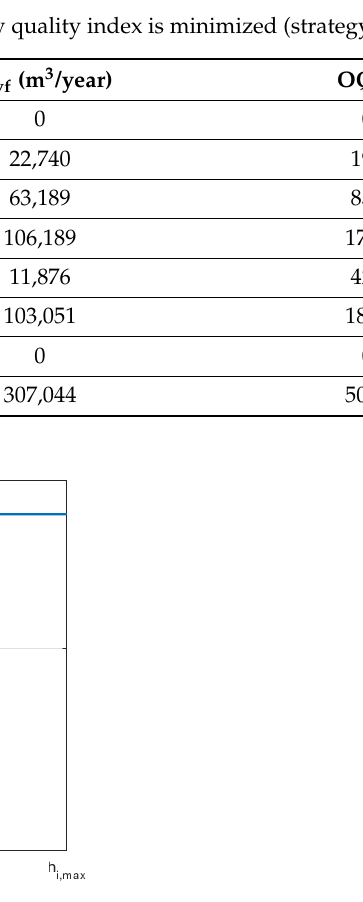
Figure 9. Strategy #2 controls depending on the liquid level in the tanks.